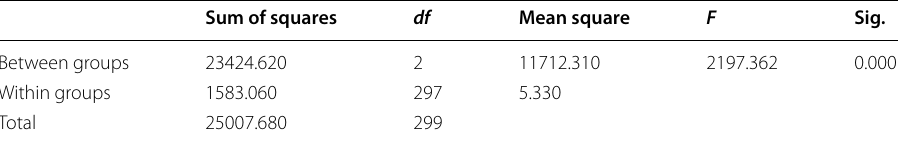
Table 1 ANOVA table for the TOEFL scores of the three groups of test takers Sum of squares df Mean square F Sig. Between groups 23424.620 2 11712.310 2197.362 0.000 Within groups 1583.060 297 5.330 Total 25007.680